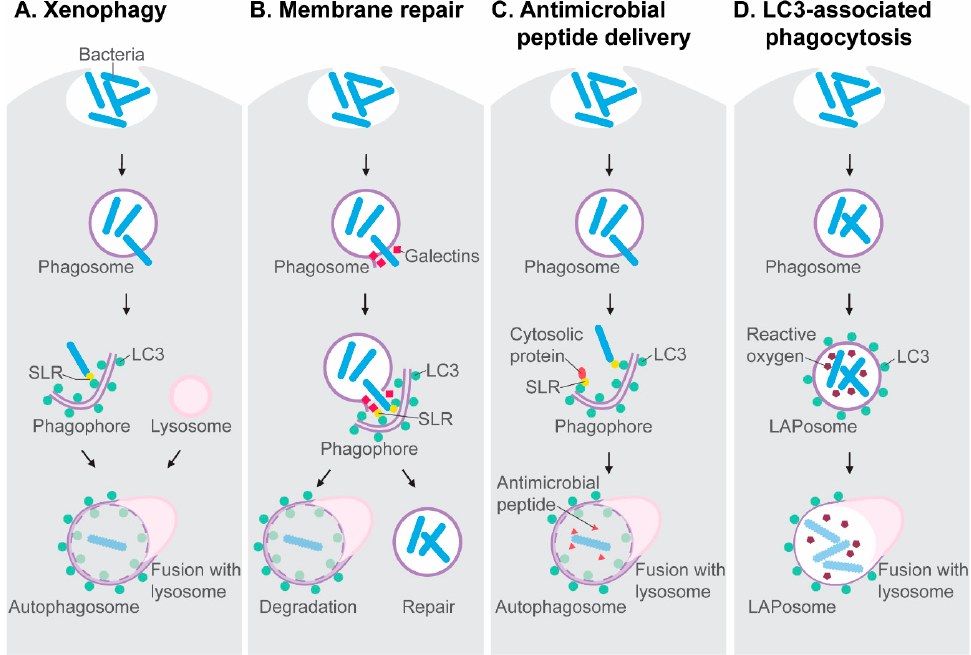
Figure 1. Antimicrobial mechanisms dependent on the autophagy machinery. ( A ) Xenophagy is a subtype of selective autophagy mediated by Sequestosome1-like receptors (SLRs) that target ubiquitinated microbes in the cytosol and interact with LC3 on nascent autophagosomes. ( B ) SLRs also detect galectins on damaged phagosomes, which may induce the autophagic degradation of these vesicles or initiate an autophagy-mediated membrane repair process, preventing microbes from entering the cytosol. ( C ) The autophagolysosomal pathway processes ubiquitinated proteins into antimicrobial peptides. ( D ) The formation of LAPosomes, where LC3 associates with phagosomes, is an autophagy-related process linked with reactive oxygen production.